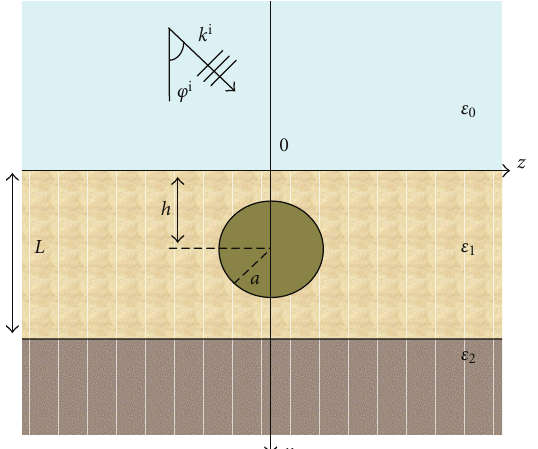
Figure 4: Geometrical layout of a buried utility.